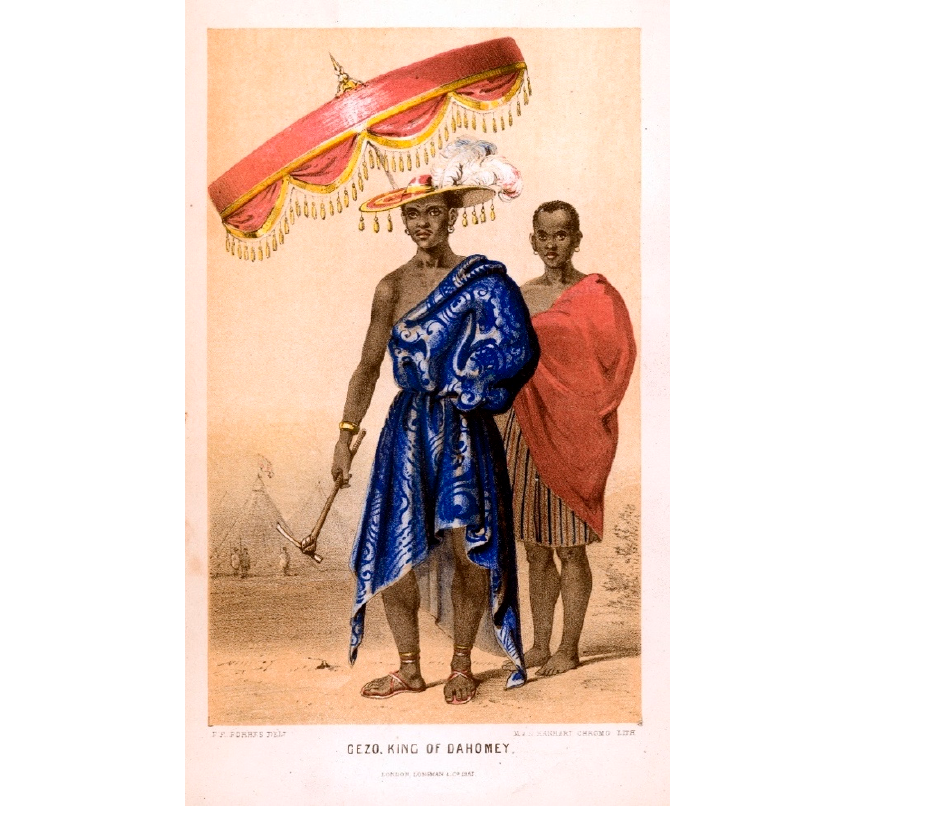
Figure 11. A lithograph of Gezo, King of Dahomey from 1818–1850, by Frederick E. Forbes, pub- lished in 1851 in London by Longman & Company. Image courtesy of the Library Company of